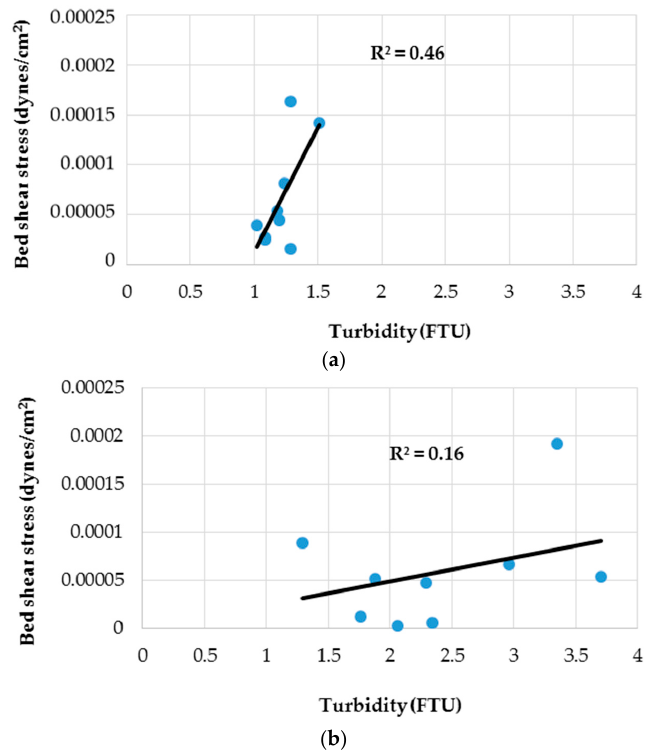
Figure 15. Correlation between the mean Landsat OLI extracted turbidities and computed bed shear stresses under ( a ) small rainfall condition and ( b ) heavy rainfall condition.